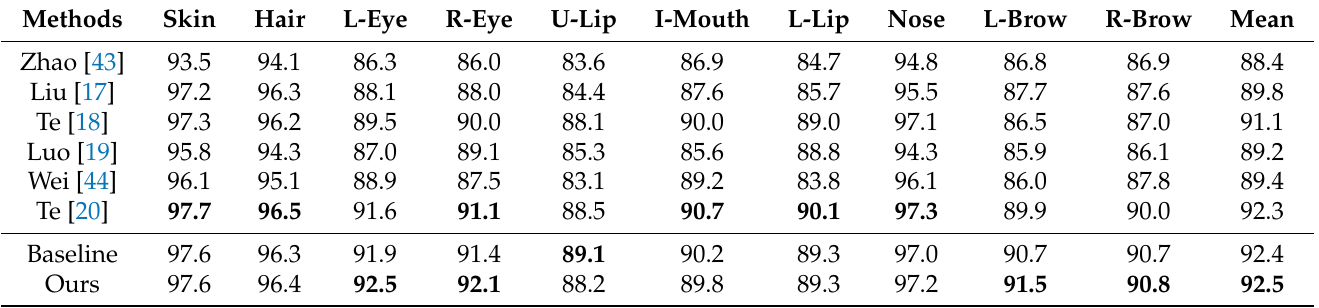
Table 2. Performance comparison between our approach and state-of-the-art methods on the LaPa test set in terms of F1 score. Bold font indicates the best results in different